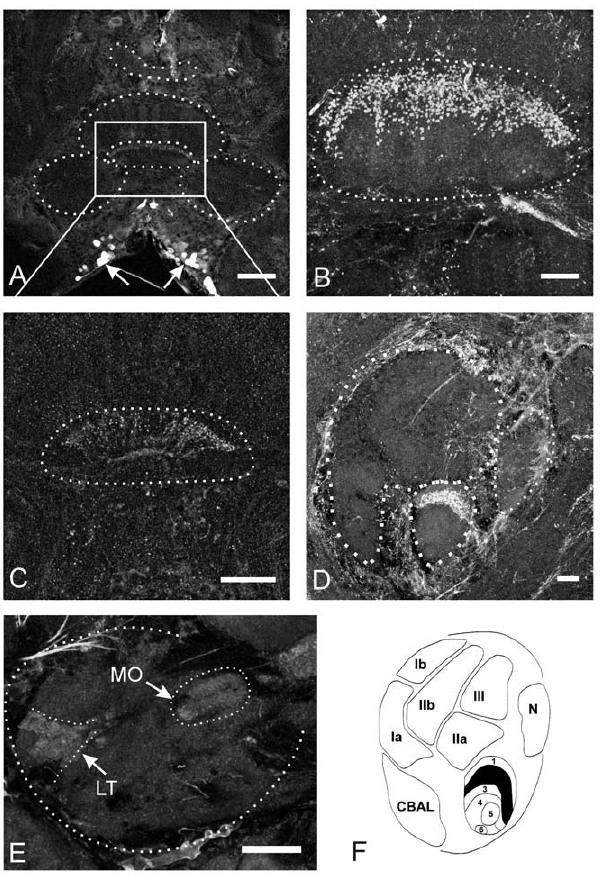
Figure 5. Nitric oxide-stimulated cGMP immunoreactivity in the central complex. A: Frontal section, through the central complex and surrounding midbrain structures. Within the central complex cGMP- ir is restricted to a particular layer of the CBL. Labeled cell bodies are located in the inferior median protocerebrum (indicated by arrows). B and C: Frontal sections through the CBL. Strong cGMP-ir is associated with fibers of tangential neurons projecting close to the anterior border of the CBL. The neurites enter the CBL from posterior direction and innervate the CBL in a fan-shaped fashion (best seen in C). Immunostaining in the CBL appears to be beaded (best seen in B and D) suggesting that labeled neurites represent presynaptic structures. D: Sagittal section through the central body: Staining in the CBL is restricted to layer II, while the other layers of the CBL and the entire CBU are completely devoid of staining (compare with F). E: Frontal section through one lateral accessory lobe (LAL) containing faint labelinginthe lateraltriangle (LT) andthe medianolive (MO). F: Schematic drawing of a sagittal section through the CB (modified from [18,21]. Regions labeled black contain cGMP immunopositive neurites. CBAL= anterior lip of the central body, N=noduli. Scale bars=100 m m in A; 20 m m in B, D and E; 10 m m in